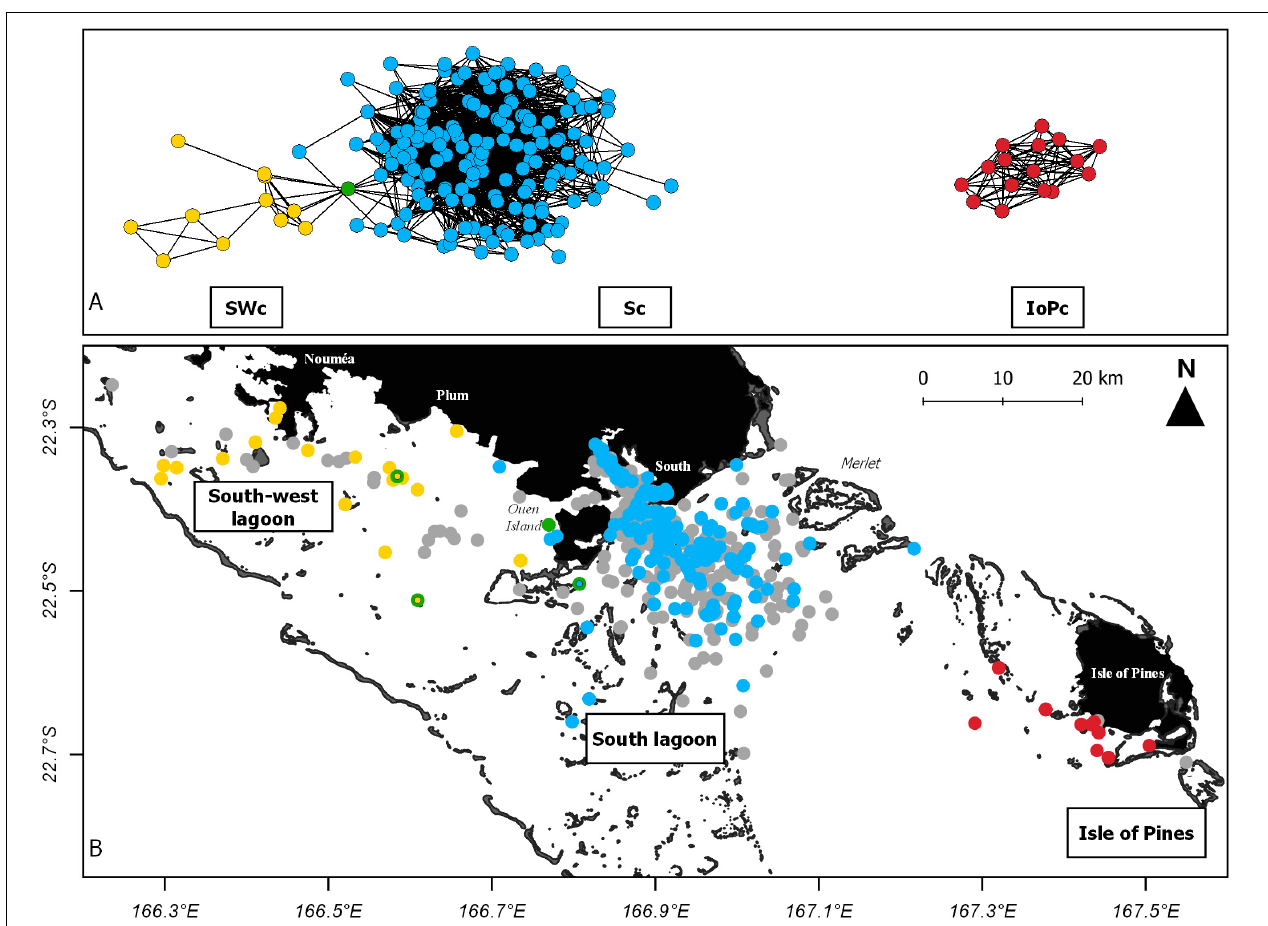
FIGURE 2 | Population structure of Indo-Pacific bottlenose dolphins photo-identified in the southern range of New Caledonia between 1997 and 2019 (winter seasons mostly). (A) Social network of interactions among individuals between three communities: the south-west community (SWc in yellow), the south community (Sc in blue) and the Isle of Pines community (IoPc in red). The green point represents an individual interacting with other dolphins from two different communities (SWc and Sc). (B) Group positions where individuals were observed. Three out of four positions of the green point represents interactions with SWc (yellow center) and Sc (blue center). Gray points represent groups recorded that have not been studied or those containing individuals observed only